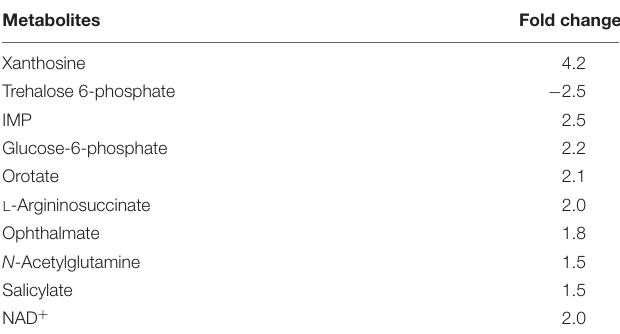
TABLE 5 | Significant fold changes in the intracellular levels of metabolites of (cid:49) cadA . Metabolites